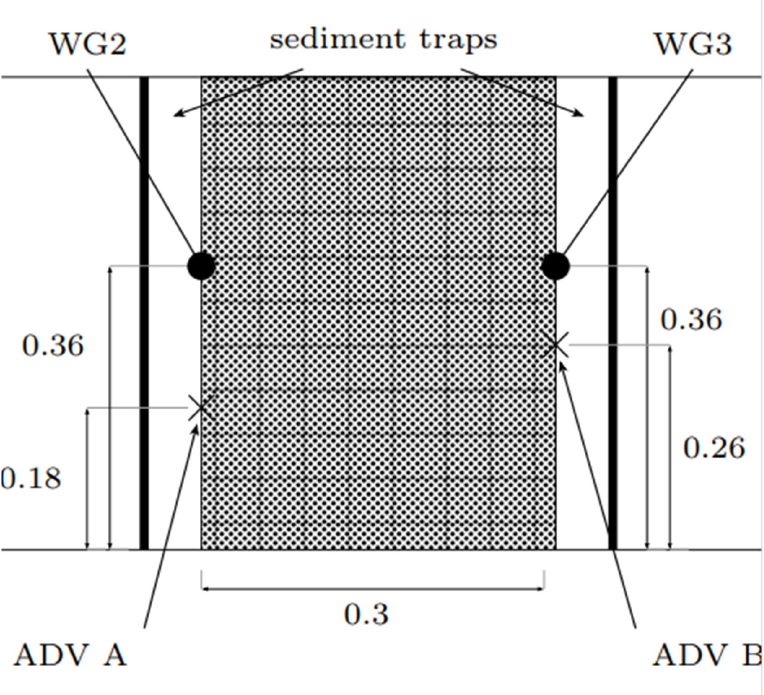
Figure 4. Close-up of the sediment section with position of gauges and sediment traps.